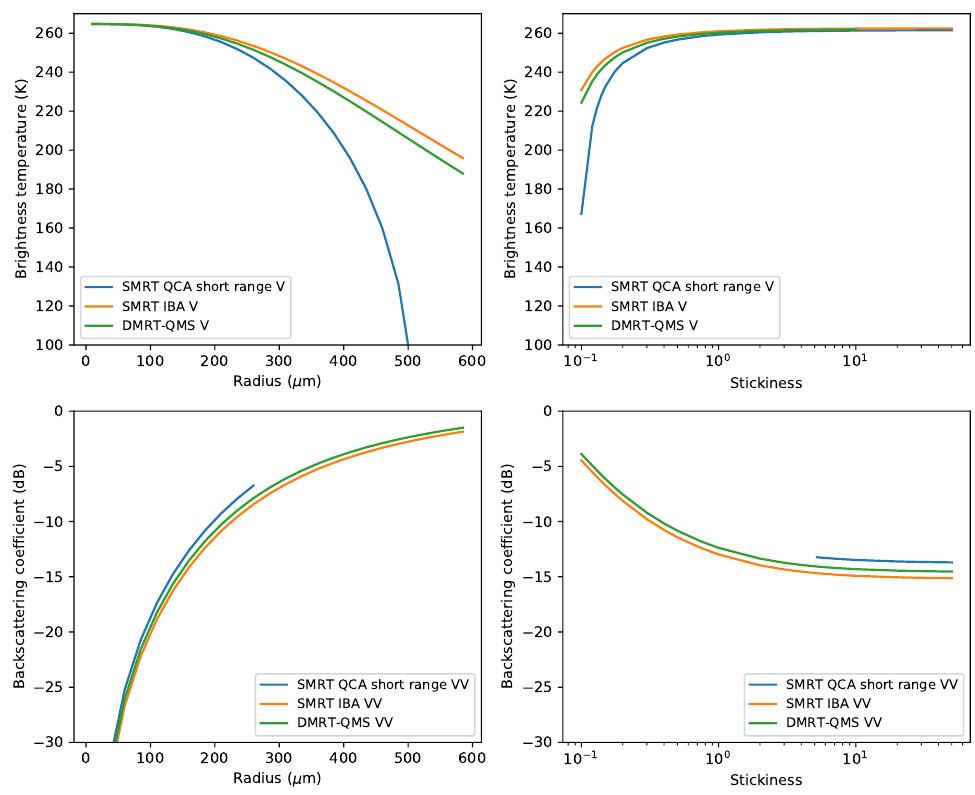
◦ ) and backscattering coefficient at VV polarization (40 ◦ ) as a function of sphere Figure 5. Brightness temperature at V polarization (55 radius and stickiness simulated by SMRT QCA, SMRT IBA with SHS microstructure, and DMRT-QMS (QCA Mie) for the same snowpack as in Fig. 4 except the radius, which is fixed to 200µm in the second column.